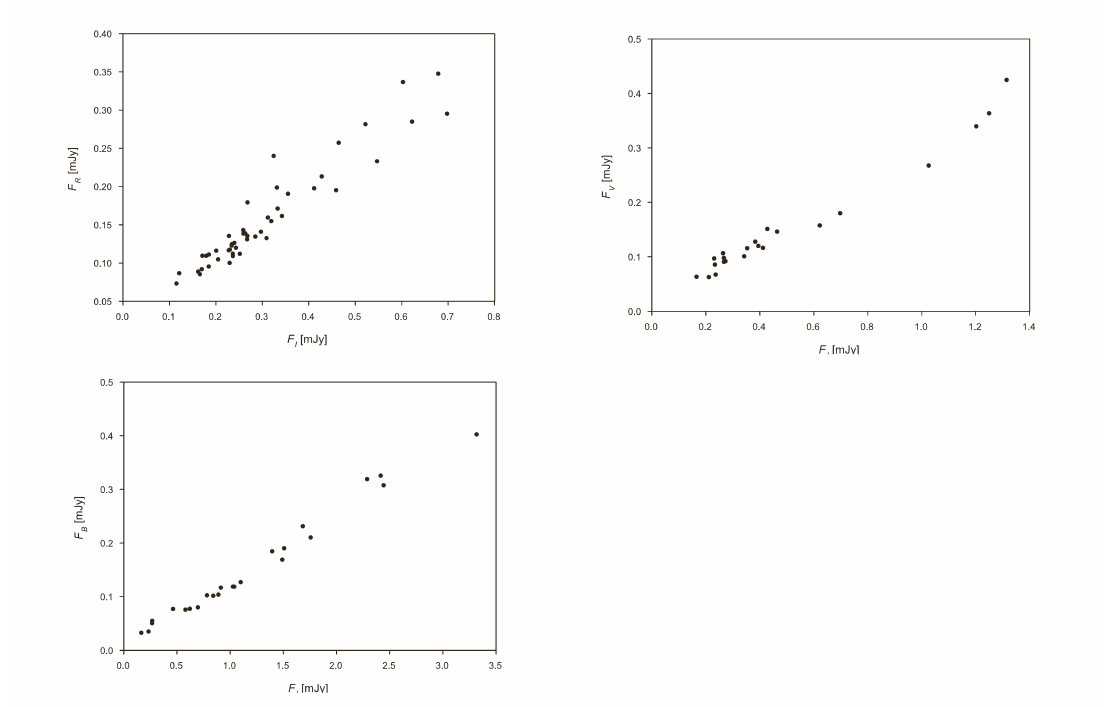
Figure 6. Flux–flux diagrams for decline